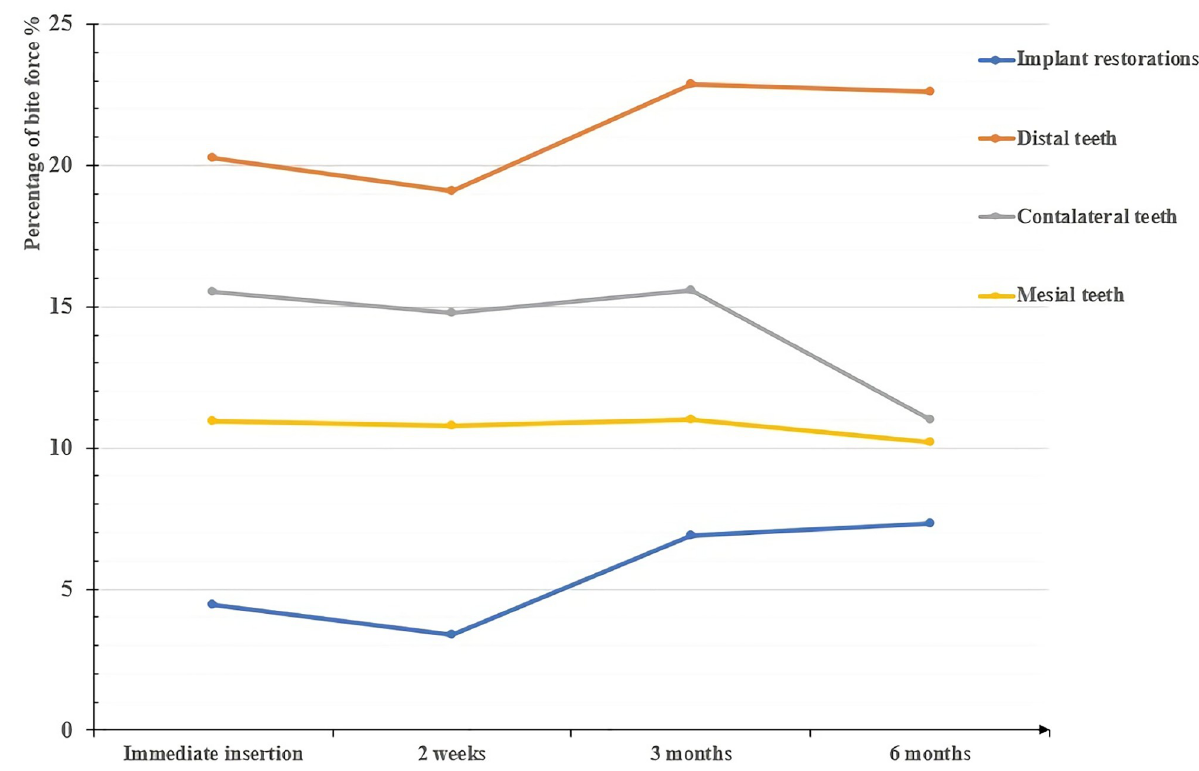
Fig 8. Changes in the average bite force distributed on the teeth and implant crowns over